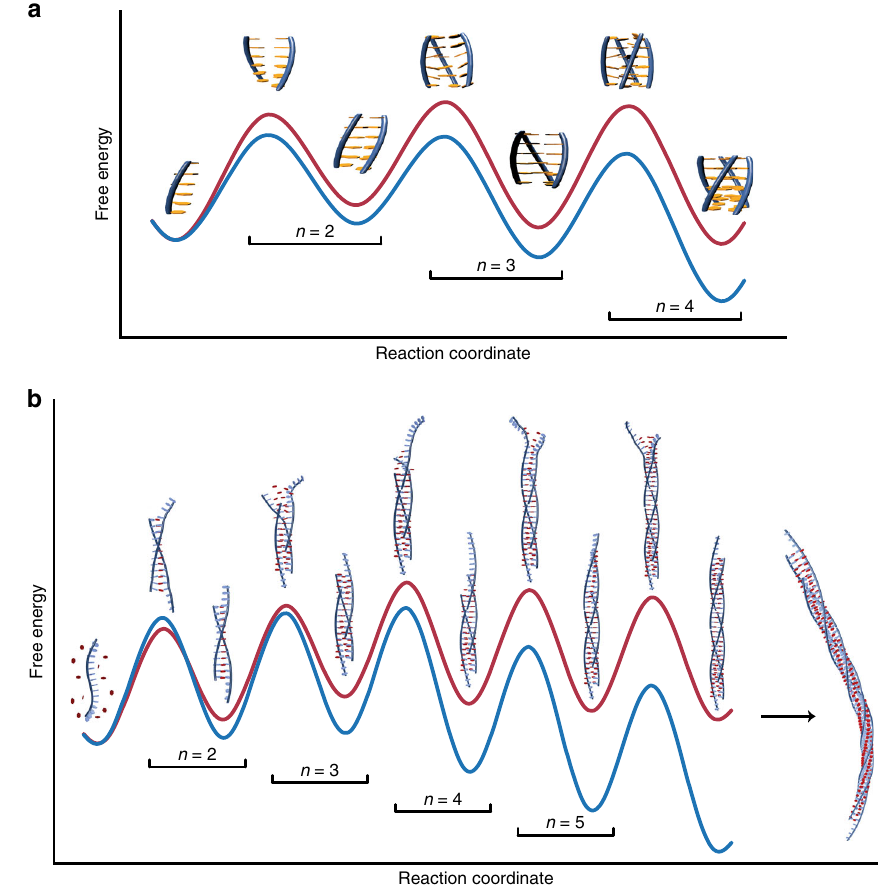
Fig. 4 Quantitative free energy diagrams for supramolecular assembly by TH. a TG 4 T assembly at 45 (red) and 5 °C (blue). At 5 °C (experimental n ≈ 2.75), the dimer barrier dominates. The trimer and tetramer barriers become dominant at 45 °C (experimental n ≈ 3.5). b Poly(A) fi ber formation at 30 (red) and 20 °C (blue) assuming a nucleus size of 3 poly(A) strands. The reaction coordinate is truncated at the hexamer. Longer fi bers form from step- wise association of monomers as indicated by the black arrow. In both panels, n values indicating assembly molecularities are given above the black